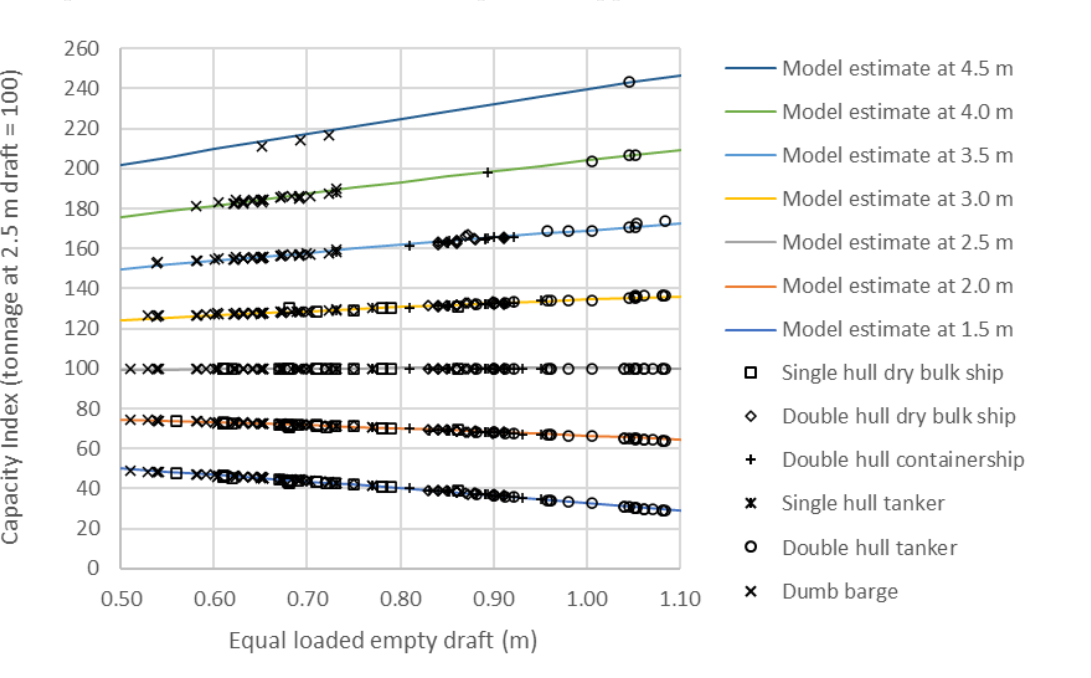
Figure 6. Observed fit of the second regression model for capacity